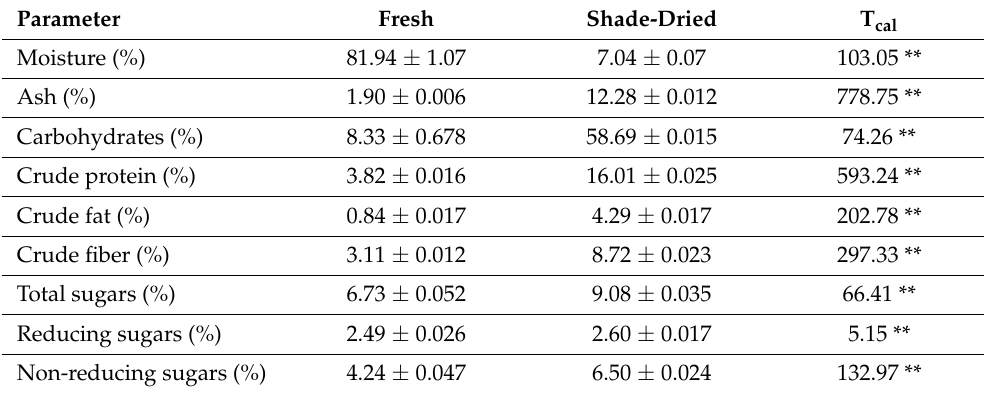
Table 1. Comparative analysis of proximate composition of T. officinale leaves (fresh and shade-dried). Parameter Fresh